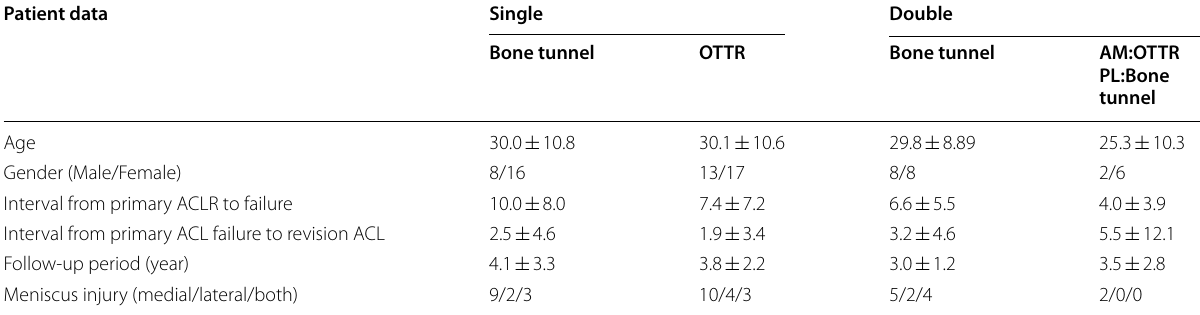
Table 2 Patient characteristics Patient